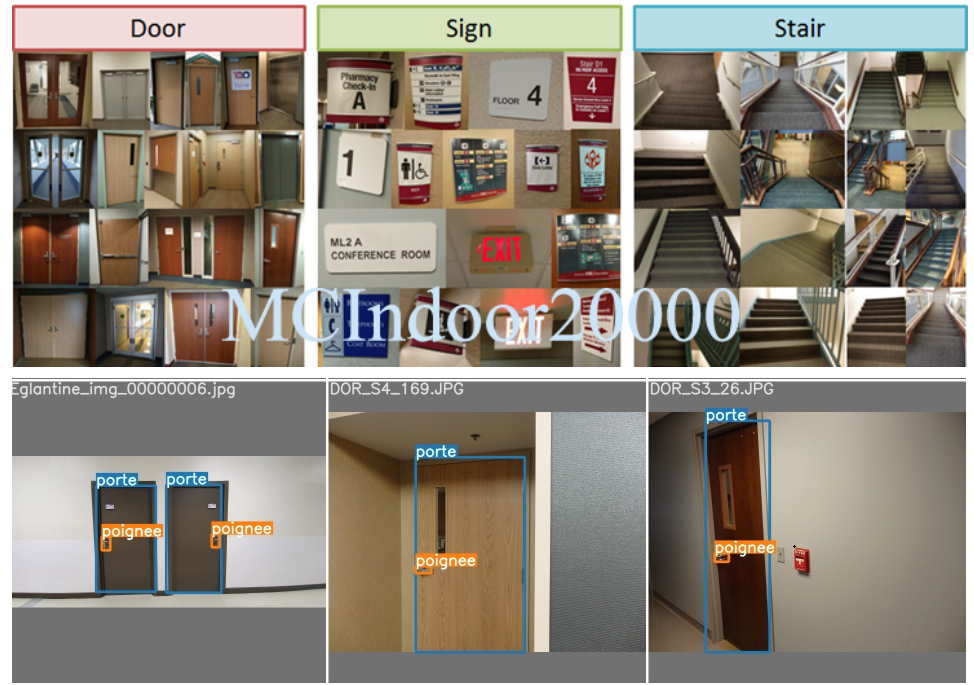
Figure 1. MCIndoor2000 dataset image sample ( top row ), custom dataset ( bottom row